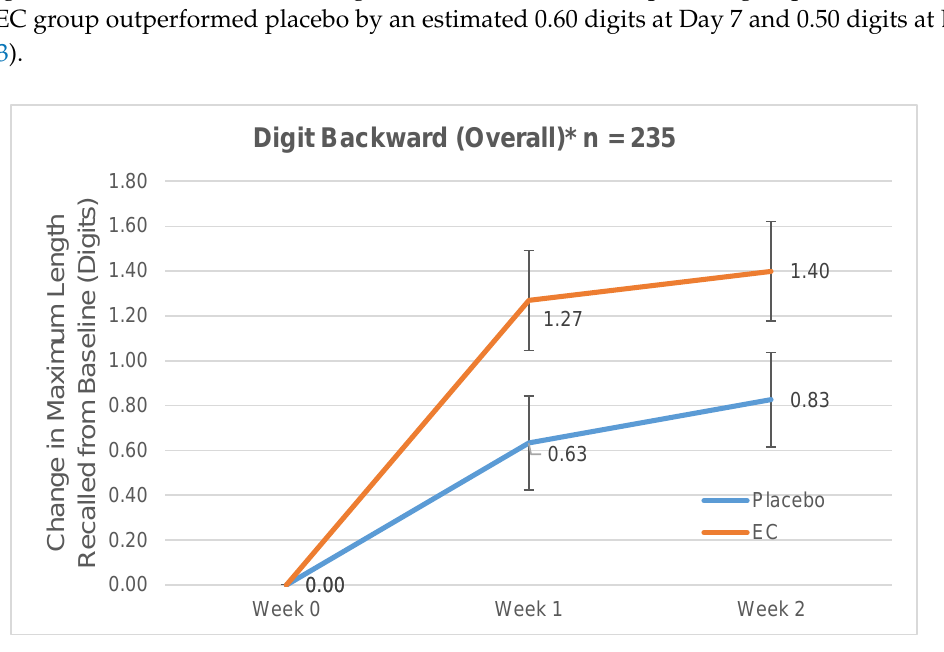
were significant in Stroop and SART tasks. For Stroop tasks, both EC and p groups improved